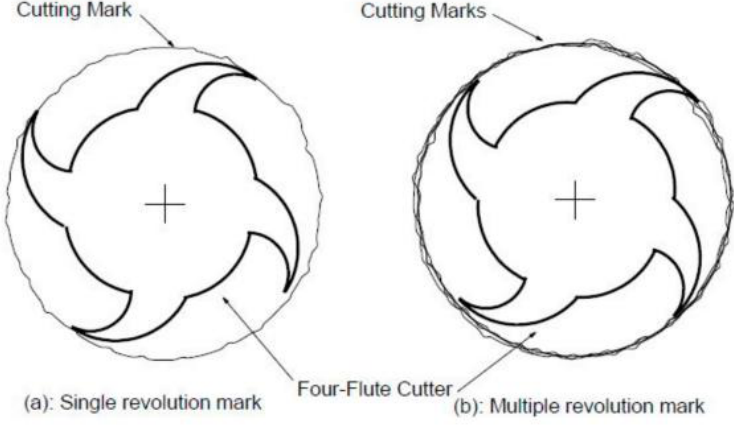
Figure 43. Machining marks after ( a ) one revolution and ( b ) multiple revolutions [37]. In this method, the depth of cut is small (e.g., 0.012 mm) so that the cutting forces are small and the tool remains sharp. Marks left by the tool at different rotational speeds are shown in Figure 44.